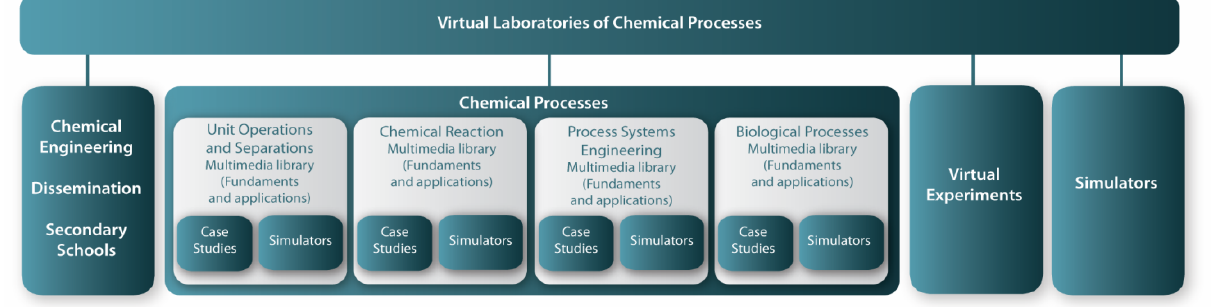
Figure 1. Scheme of the platform